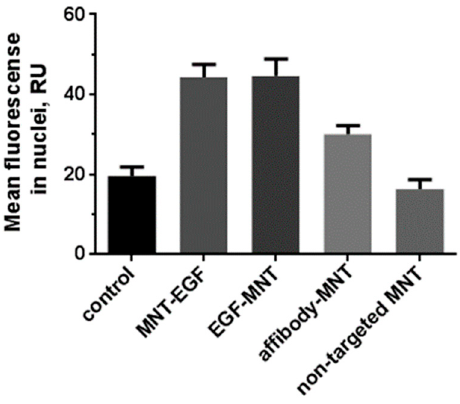
Figure 5. Uptake of various modular nanotransporters (MNTs) by M3-EGFR cells as determined by immunofluorescent analysis. The value of the average fluorescence of the nuclei of M3-EGFR cells fixed after a two-hour incubation with the following MNTs: non-targeted MNT (n = 37), MNT-EGF (n = 118), EGF-MNT (n = 75) and affibody-MNT (n = 79). Data are presented as means ±95% CI. RU—relative units.